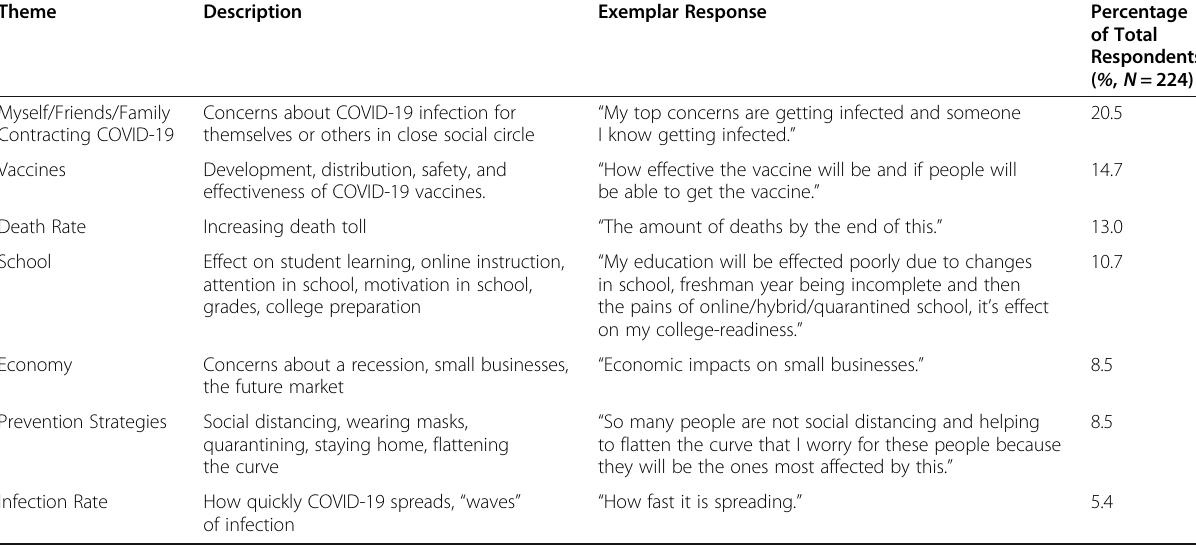
Table 3 Thematic Analysis of Student Concerns about